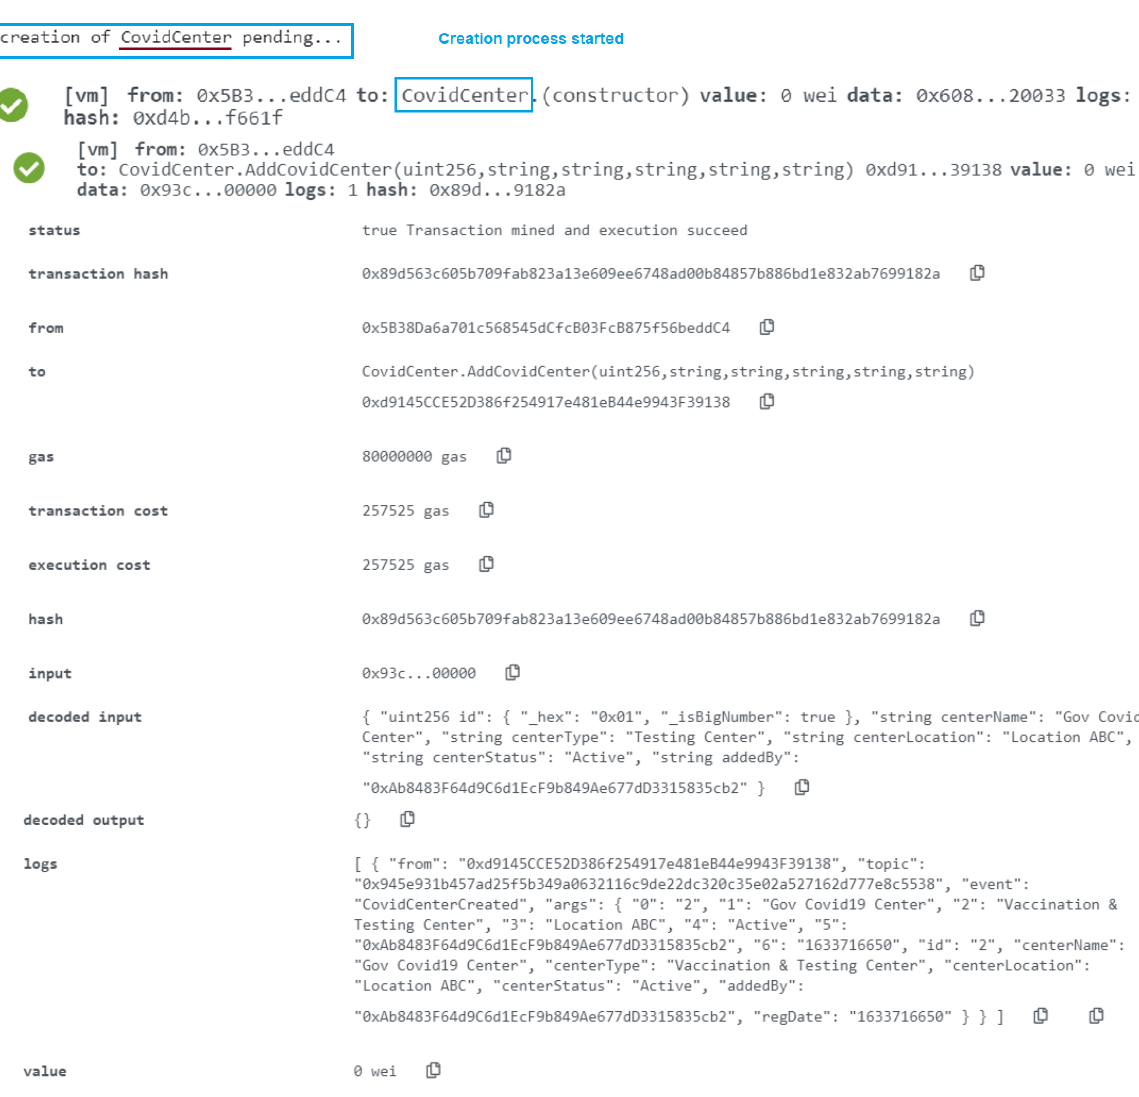
Figure 9. Add COVID ‐ 19 Centers in the blockchain